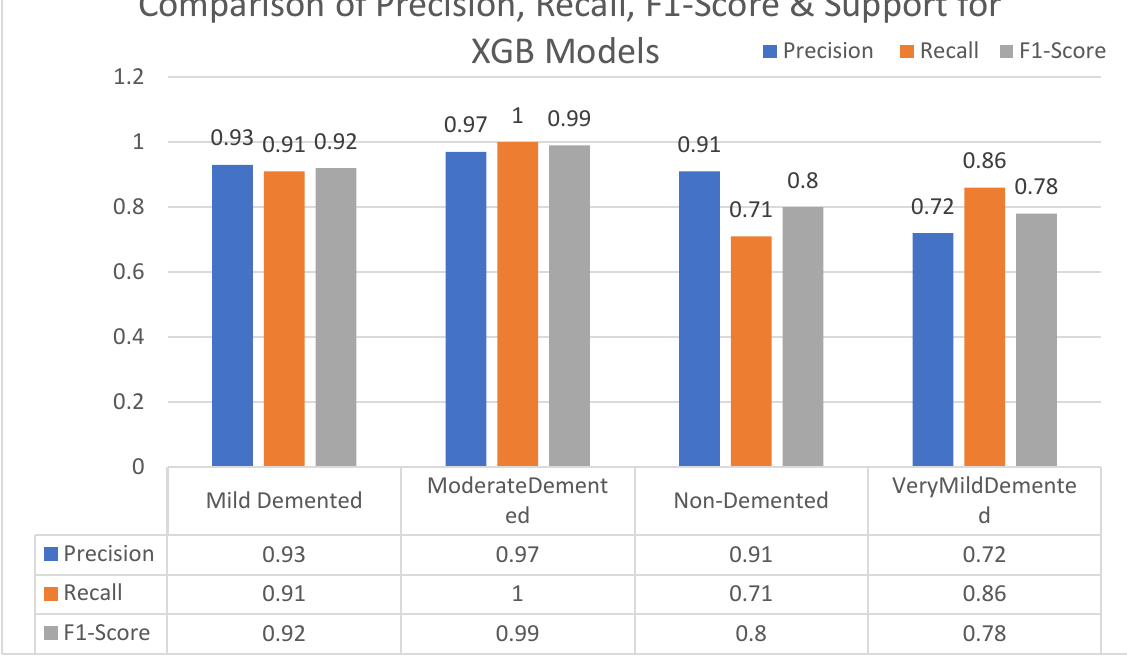
Figure 9. Visualization of Diagnostic Test for XGB Model.